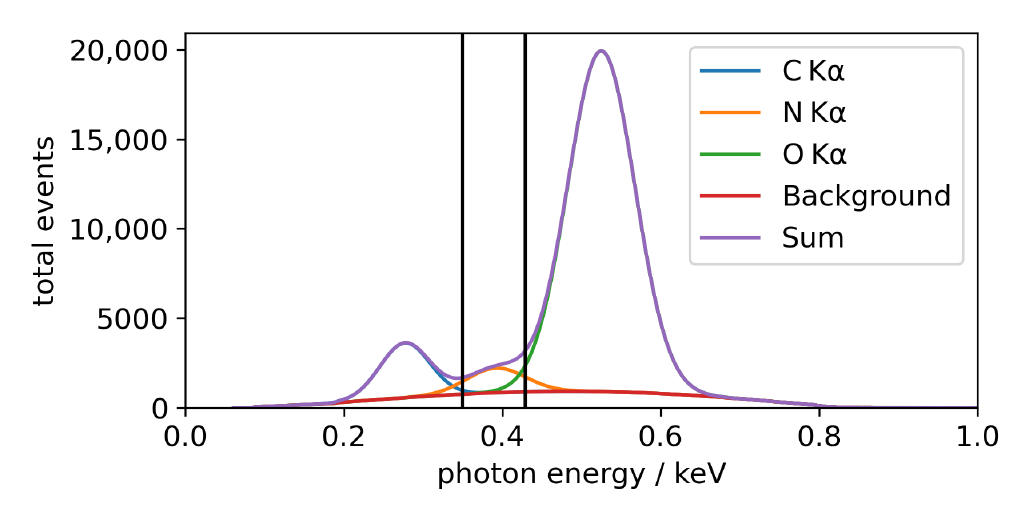
Figure 4. Fit result of the energy-dispersive spectrum of the BESSY II measurement at the area of the N K α interference pattern at θ = 1.58° and ϕ = 0°. The C K α , N K α and O K α fluorescence line profiles fitted by Specfit [31] are shown, together with the subtracted background. The sum spectrum is also shown. The black vertical lines denote an exemplary ROI from 350eV to 430eV for N K α